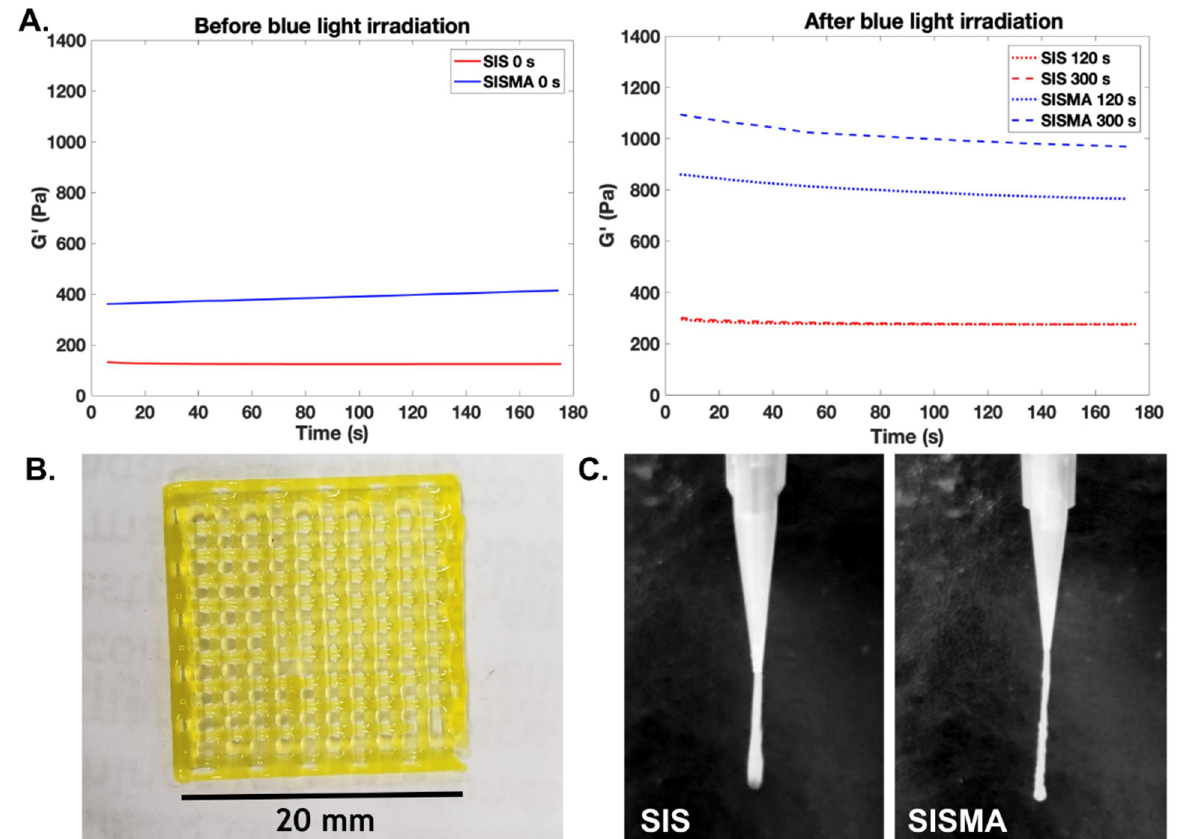
Figure 2. ( A ) Methacryloyl-modified small intestine submucosa dECM (SISMA) hydrogel bioprinted into a square lattice with high shape fidelity. ( B ) Filament formation of unmodified SIS and SISMA hydrogels made at the same ECM concentration (25 mg/mL) upon extrusion as a key feature for adequate printability. ( C ) Storage modulus of unmodified-SIS and SISMA hydrogels before and after photocrosslinking with varying exposure time. SISMA hydrogels exhibit superior mechanical stability, before and after blue light irradiation, and superior crosslinking dynamics.